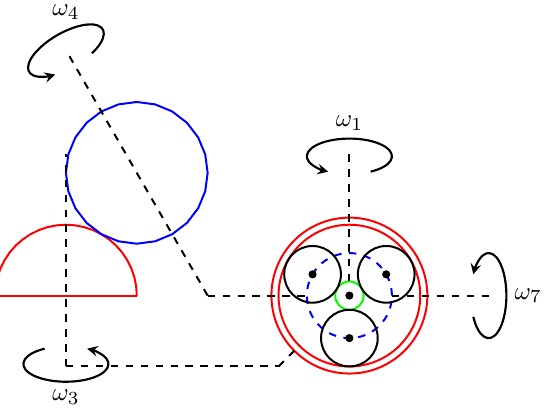
Figure 5. Transmission ratio of PS-CVT and DH-CVT.